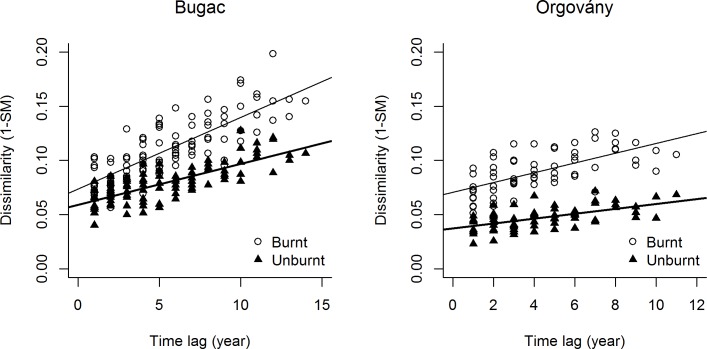
The compositional dissimilarity as a function of time lag on the two sites.Trend lines for illustrative purpose are fitted for significant relationships (bold for unburnt, simple line for burnt areas) according to Mantel-tests.